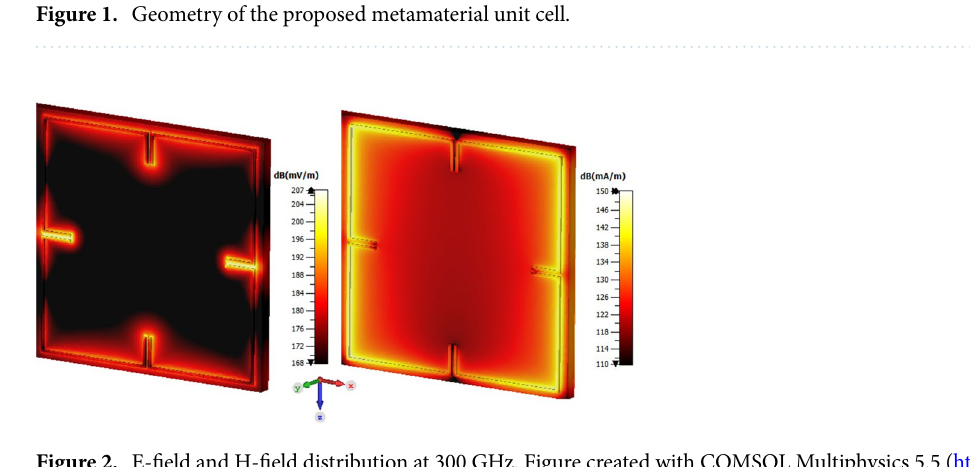
Figure 2. E-field and H-field distribution at 300 GHz. Figure created with COMSOL Multiphysics 5.5 (https:// www. comsol.